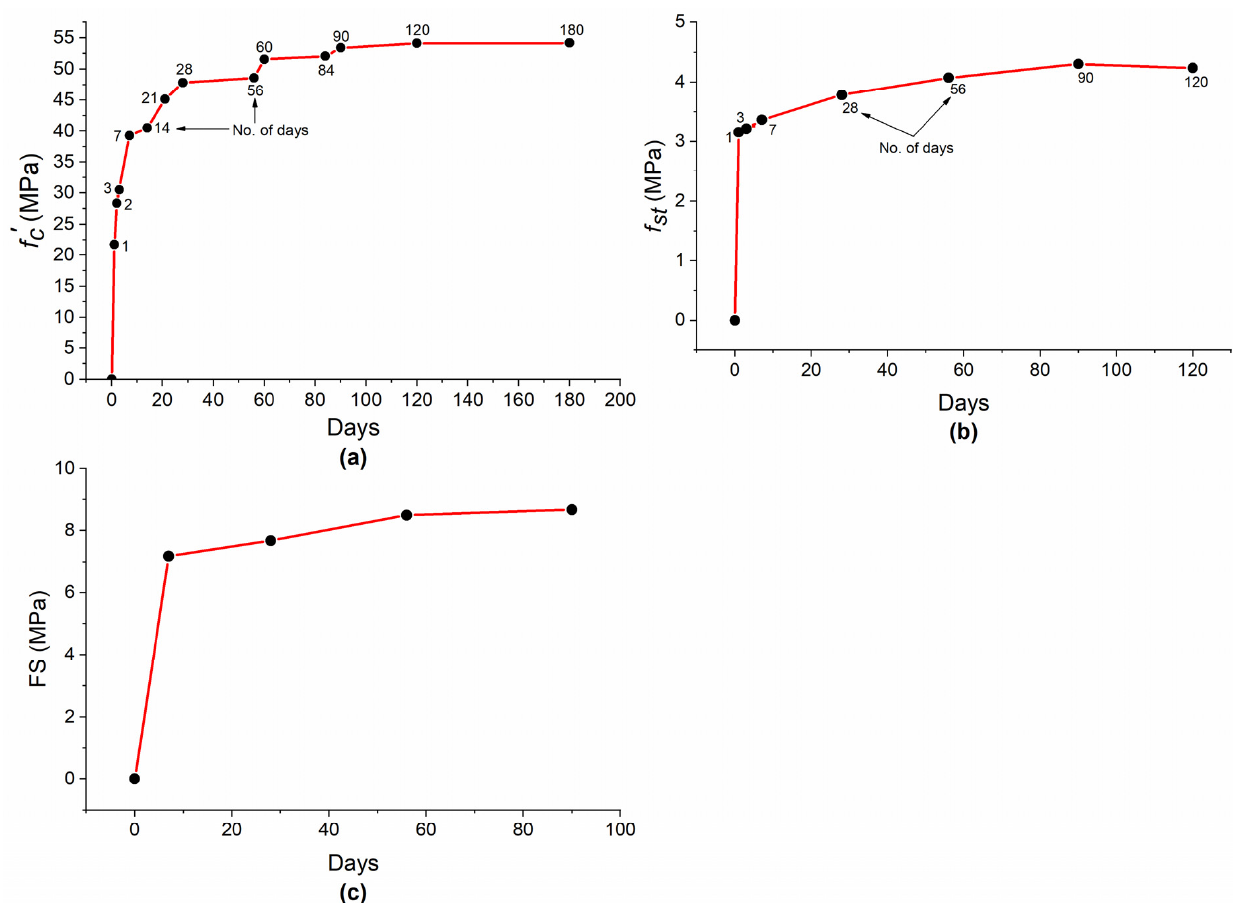
Figure 26. Variation in mechanical properties of concrete with age: ( a ) (cid:1858)′ (cid:2913) ; ( b ) (cid:1858) (cid:2929)(cid:2930) ; ( c ) FS